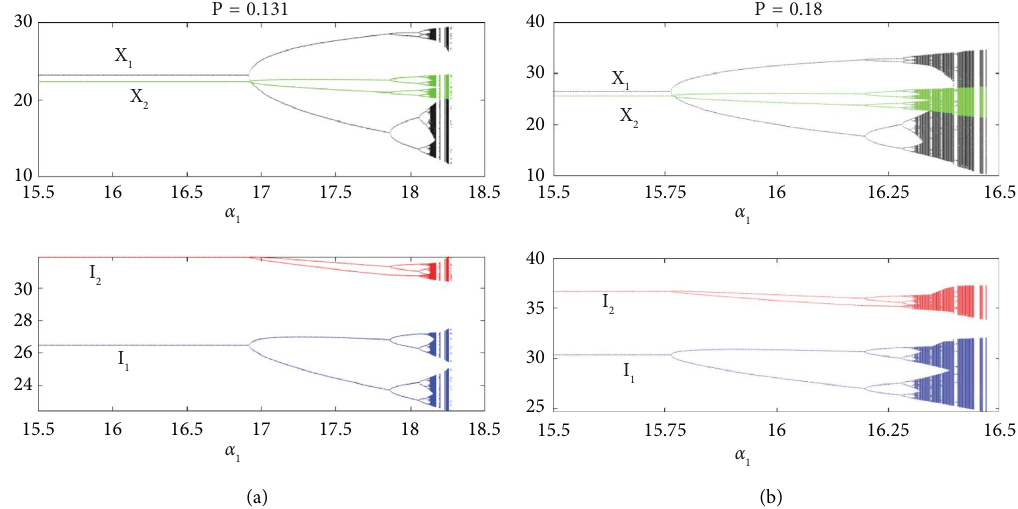
Figure 3: Te bifurcation diagram of the discrete dynamic system (8) with the adjustment speed α price P of the credits